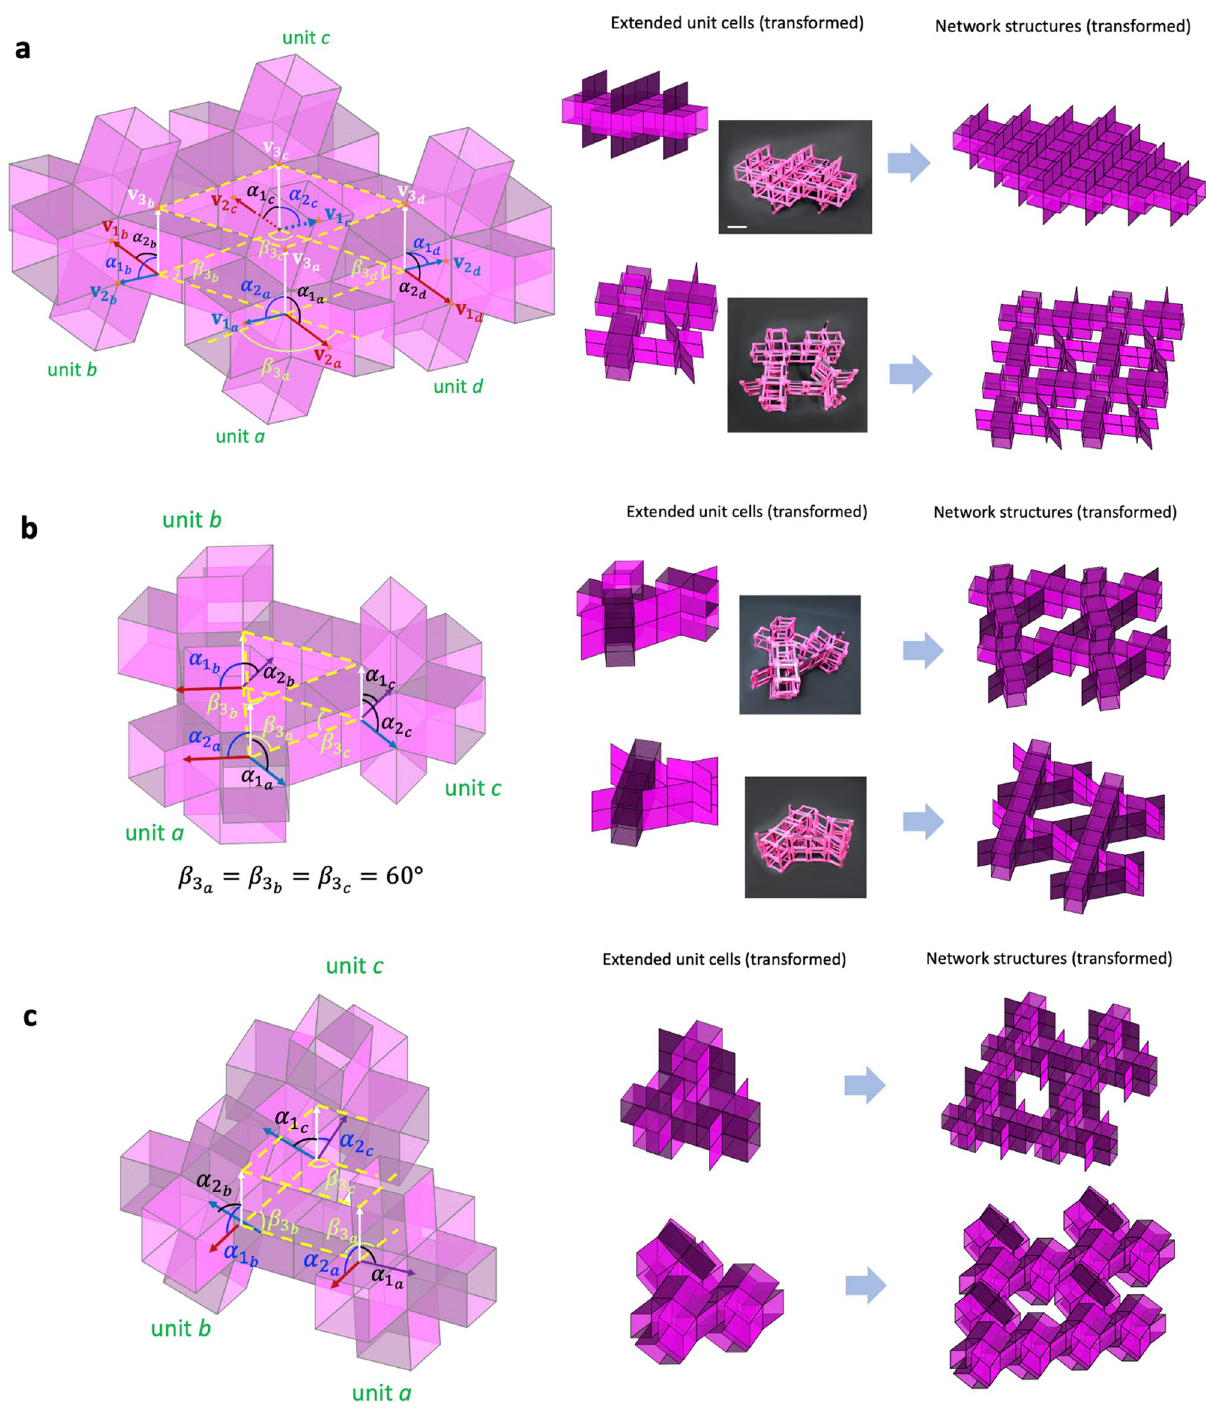
Figure 3. Angular kinematics of motion of 2D extended unit cells and selective transformations: ( a ) square closed-loop (Supplementary Video 2), ( b ) triangular closed-loop, and ( c ) no-loop